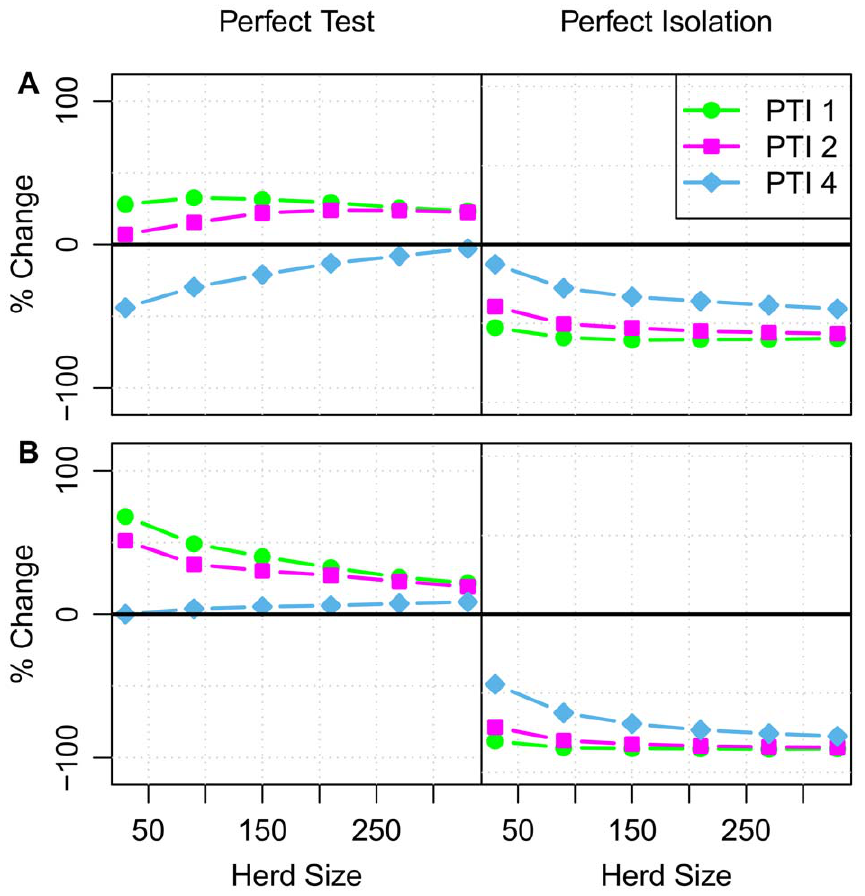
Figure 4. Impact of herd-level interventions on probability of recurrence within 24 months. Change in the probability of a herd experiencing a recurrent breakdown after application of a ‘perfect’ test (left column) or perfect isolation (right column). The perfect test is assumed to have 100% sensitivity and specificity and no occult period. Perfect isolation corresponds to setting the extrinsic infectious pressure to zero at the end of a breakdown ( x ~ 0 ). Plotted values correspond to the average % difference in the probability of recurrence relative to the fitted SORI (Panel A ) and SOR models (Panel B ). Separate series are plotted for herds in PTI 1 (lime green circles), 2 (magenta squares) & 4 (sky blue diamonds). Predictive distributions illustrating the variability in these point (mean) estimates are presented in supplementary figure S13